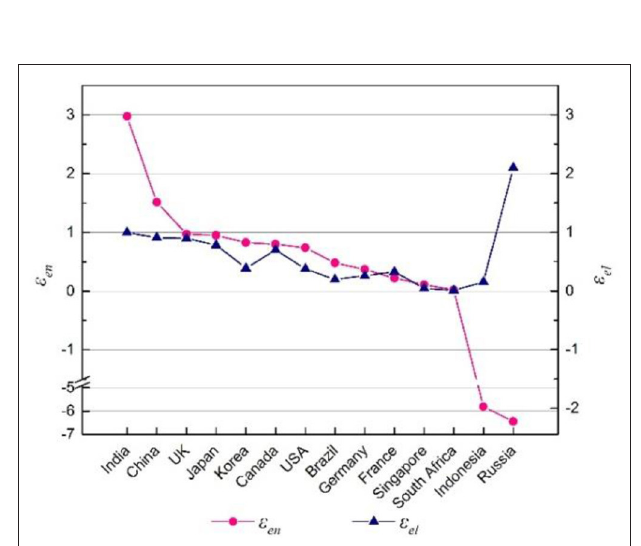
FIGURE 5 | Change rate of economic resilience to energy/electricity